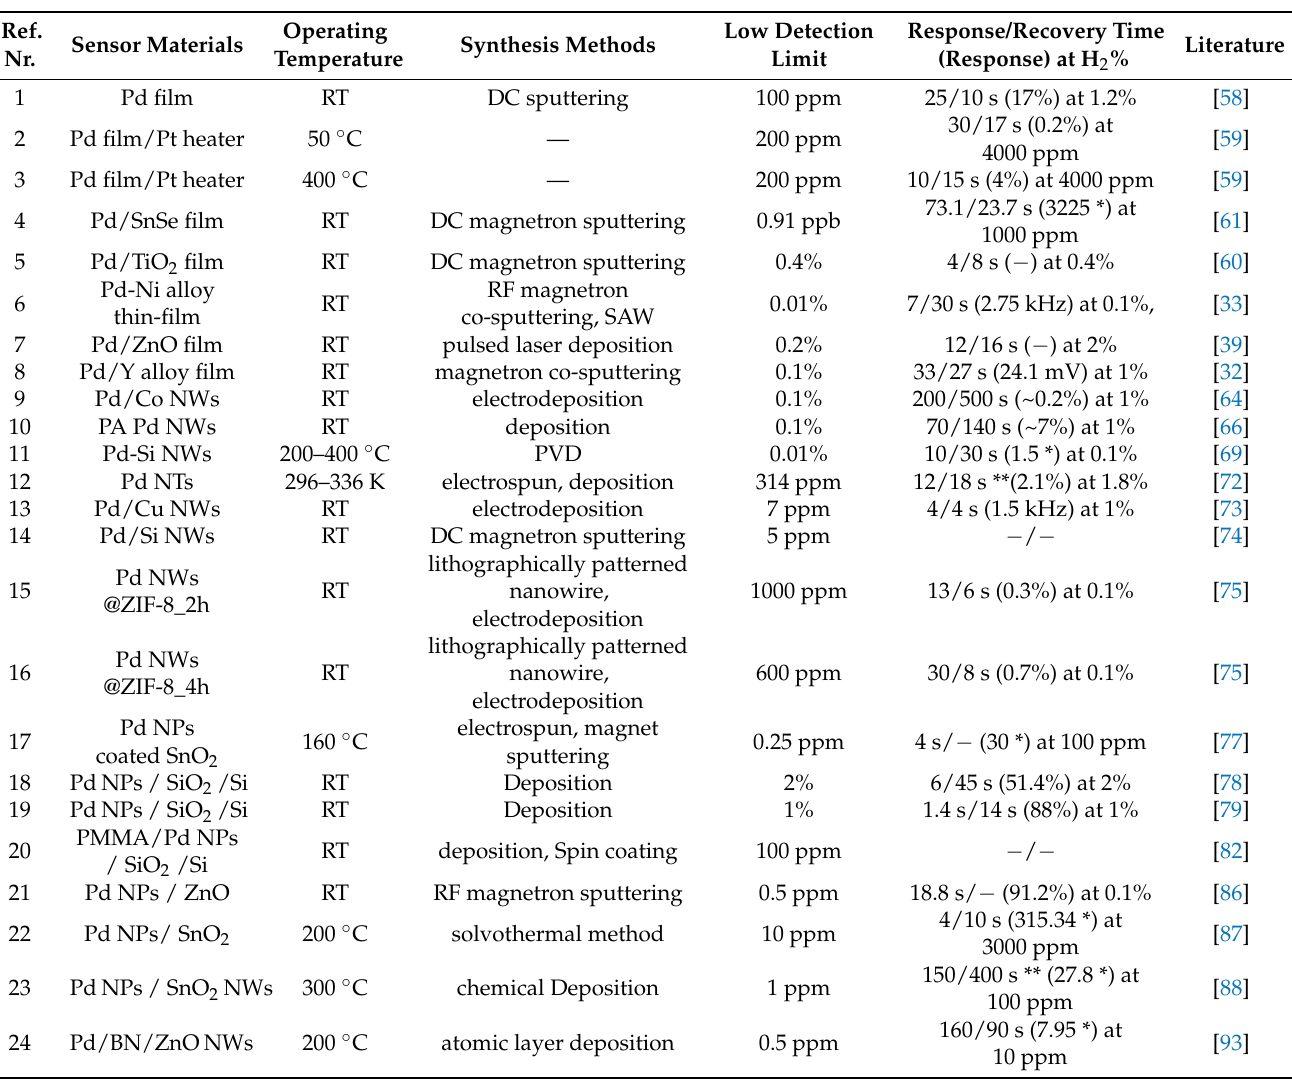
Table 1. Comparison of sensing performances towards hydrogen gas of Pd-based gas sensors in literature. Unless specified, the sensor response is defined by the given Equation (1). (*) Sensor response given by the form R a /R g . (**) The recovery times were not given directly in their publications and were approximately read out from the sensing response curves. RT: room temperature, DC: direct current, RF: radio frequence, SAW: surface acoustic wave, PVD: physical vapour deposition.